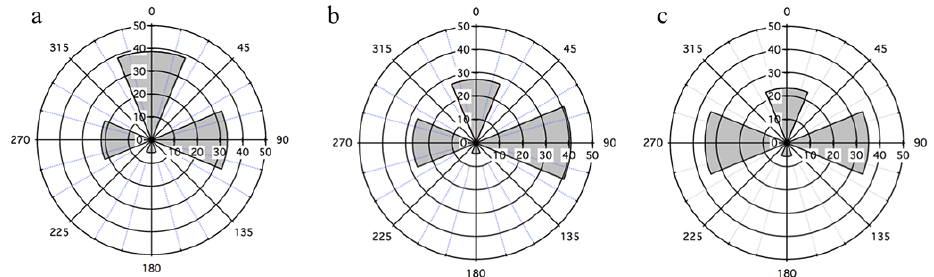
Figure 10. Wind rose plots based on the HYSPLIT backward air mass trajectories showing measured wind direction (degrees) and frequency (%), for (a) ODEs, (b) MODEs, and (c) non-ODEs observed during the two O-Buoy Beaufort Sea deployments (see Fig. 1; Table